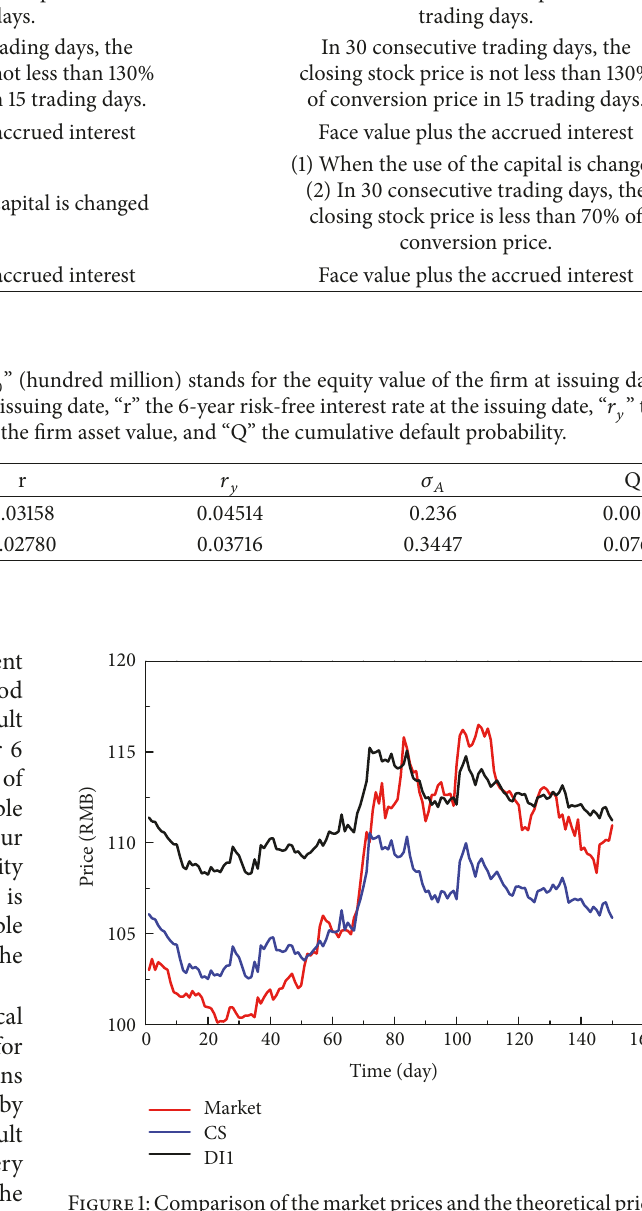
Figure1:Comparisonofthemarketpricesandthetheoreticalprices of CEB convertible bond calculated by CS method and DI method with supposition that a default may occur only on the maturity date